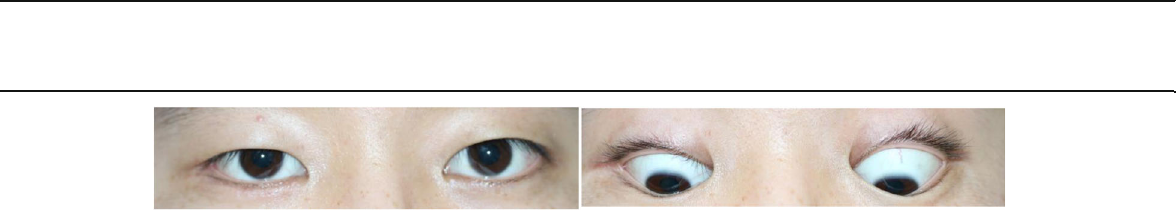
Fig. 6 The inconspicuous scar and mild downward gaze